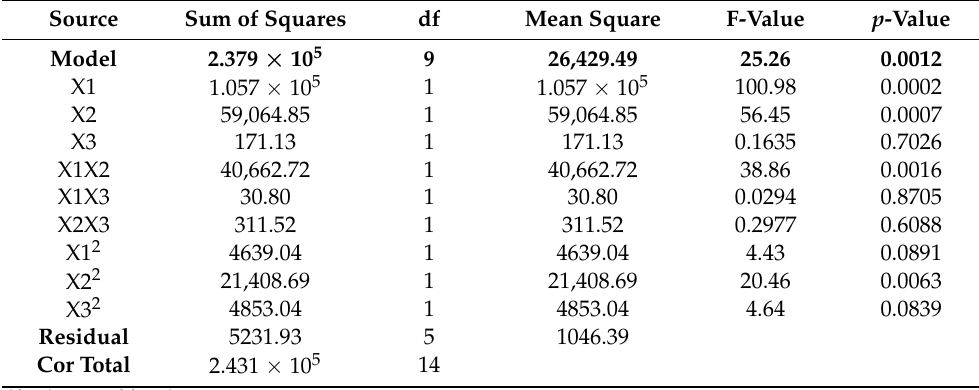
Table 8. ANOVA for Quadratic model of particle size (Y1).